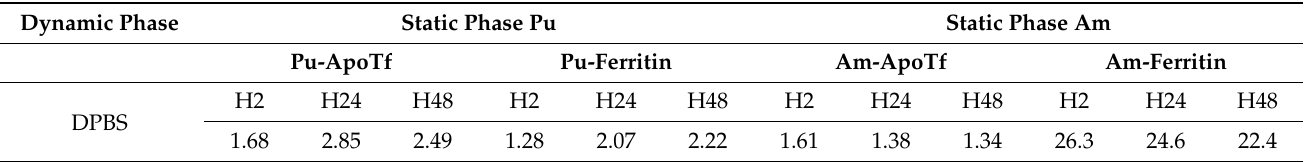
Table 3. Transfer enhancement of Pu/Am-protein complexes in the absence of ligands in the dynamic phase. Enhancement factor of transferred activity for protein-actinide complexes vs. uncomplexed “free” actinide (H2). Ratio of medians are from two experiments performed in triplicate. Dynamic Phase Static Phase Pu Static Phase